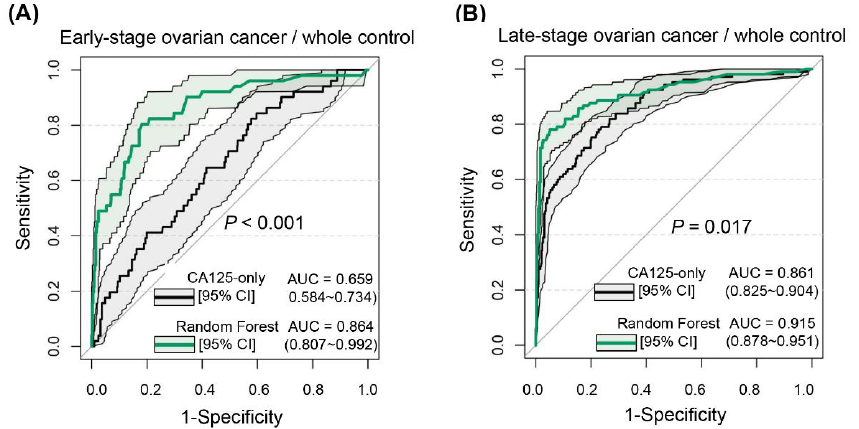
Figure 5. Receiver operating characteristic curves for different stages of ovarian cancer diagnosed by random forest. ( A ) Early-stage (International Federation of Gynecology and Obstetrics (FIGO) stages I–II) ovarian cancer versus overall control group. ( B ) Advanced-stage (FIGO stages III–IV) ovarian cancer versus overall control group.